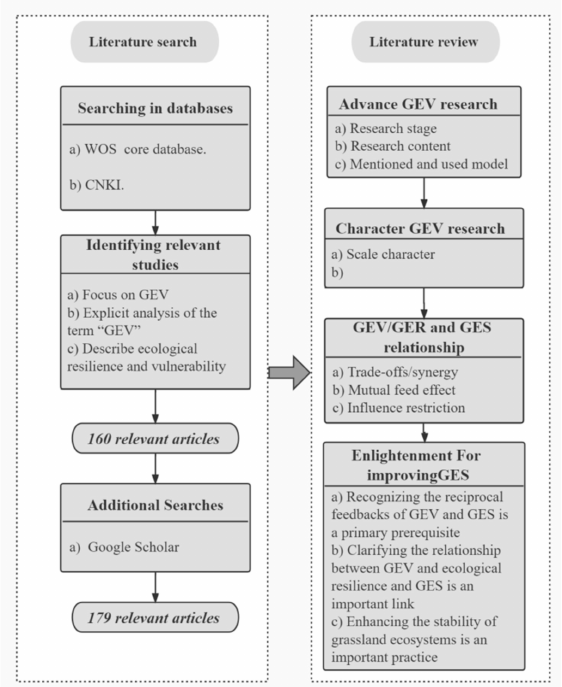
Figure 1. Flowchart showing the systematic literature search and literature review. “Trade- offs/synergy”: Trade-offs are situations in which the supply of some types of ecosystem services decreases as the use of other types of ecosystem services increases, while synergies are situations where two or more ecosystem services are enhanced simultaneously. “Mutual feed effect”: Mutual feedback effects, to a certain extent, are mutual causes and effects. “Influence restriction”: Certain restrictions or limitations on one another. GEV, grassland ecosystem vulnerability; GER, grassland ecological resilience; GES, grassland ecosystem